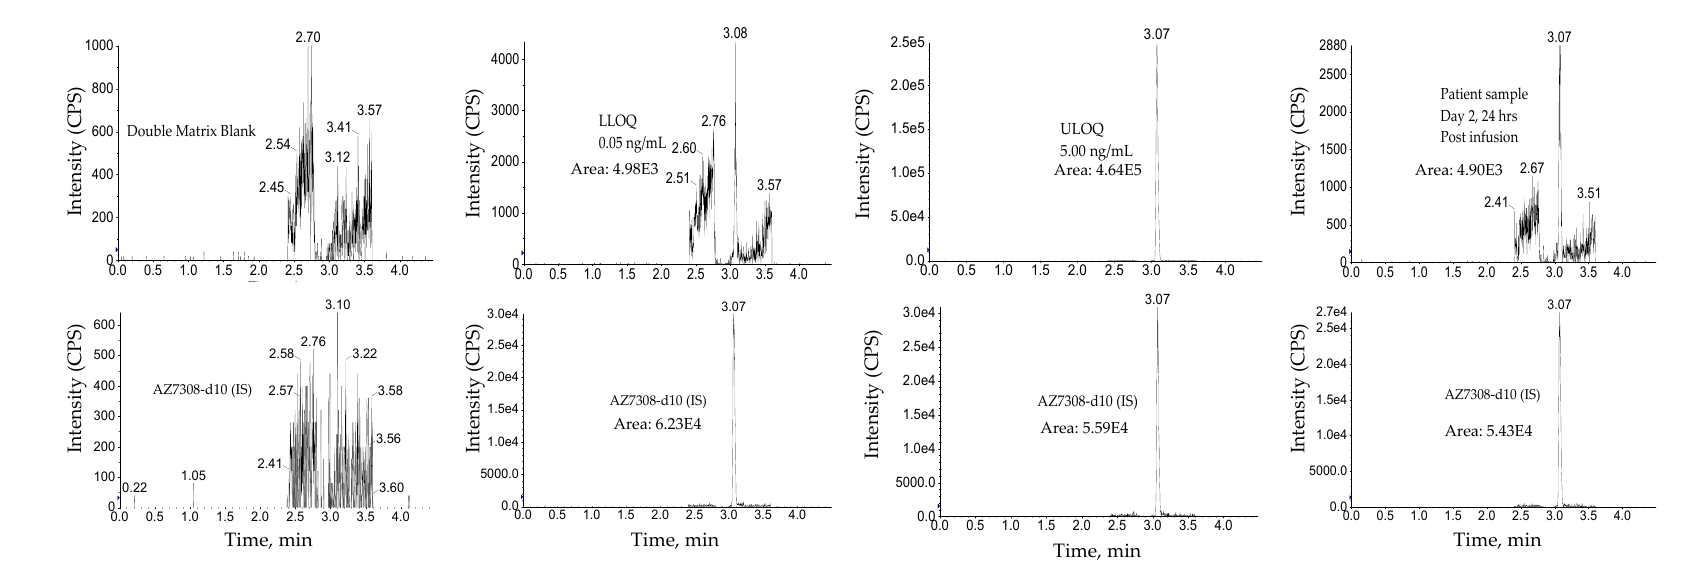
Figure 8. Representative chromatograms. ( A ) Unconjugated AZ13599185 (AZ9185) assay. ( B ) Unconjugated AZ13687308 (AZ7308) assay. Peak areas were quantified using Analyst IntelliQuan processing algorithm with a smoothing factor of